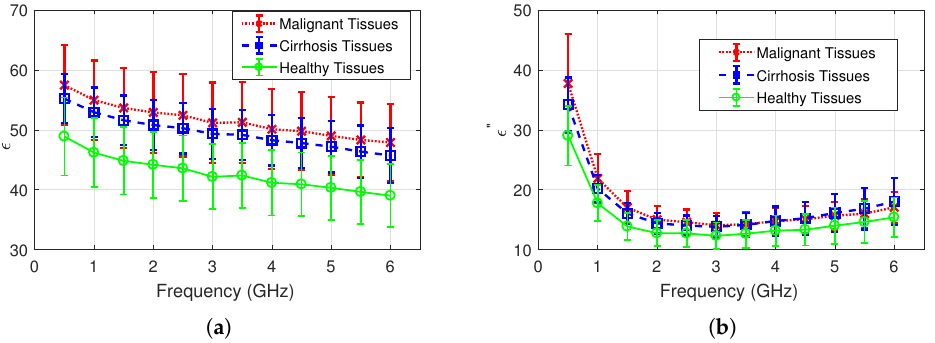
Figure 3. Measured dielectric properties of healthy and diseased rat liver tissues: ( a ) relative permittivity comparison of malignant, cirrhosis, and healthy rat liver; ( b ) dielectric loss comparison of malignant, cirrhosis, and healthy rat